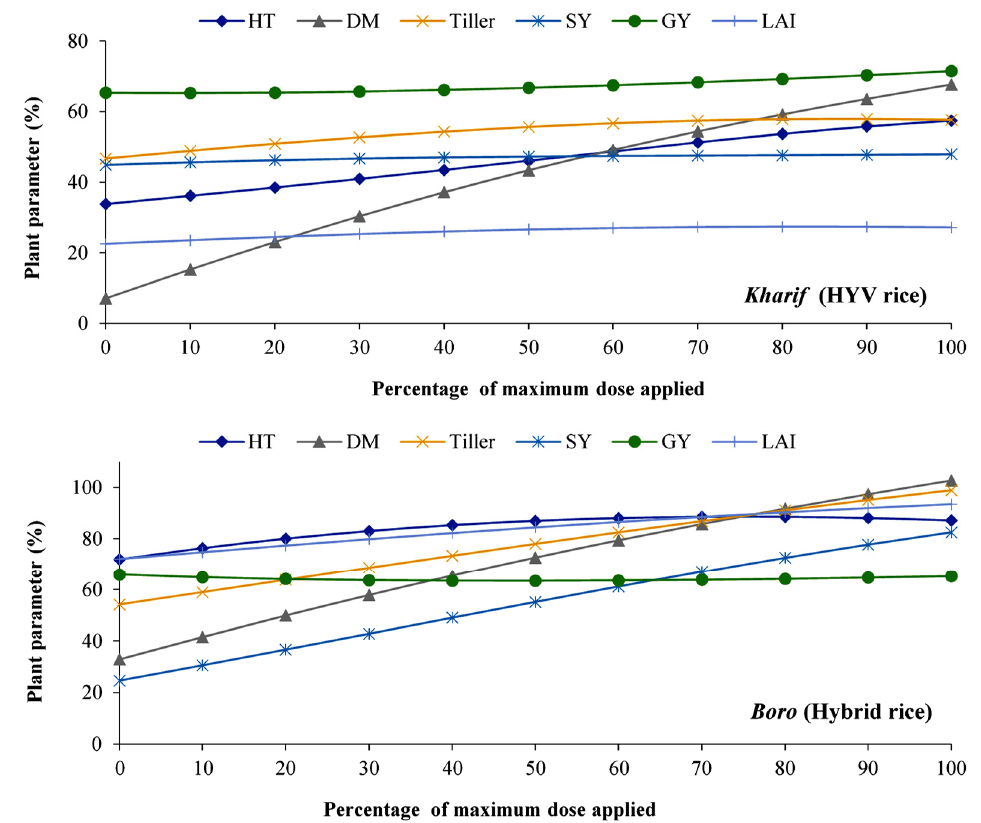
Figure 6. Effect of sulfur on different plant parameters of kharif and boro season rice. For notation, see Figure 2.